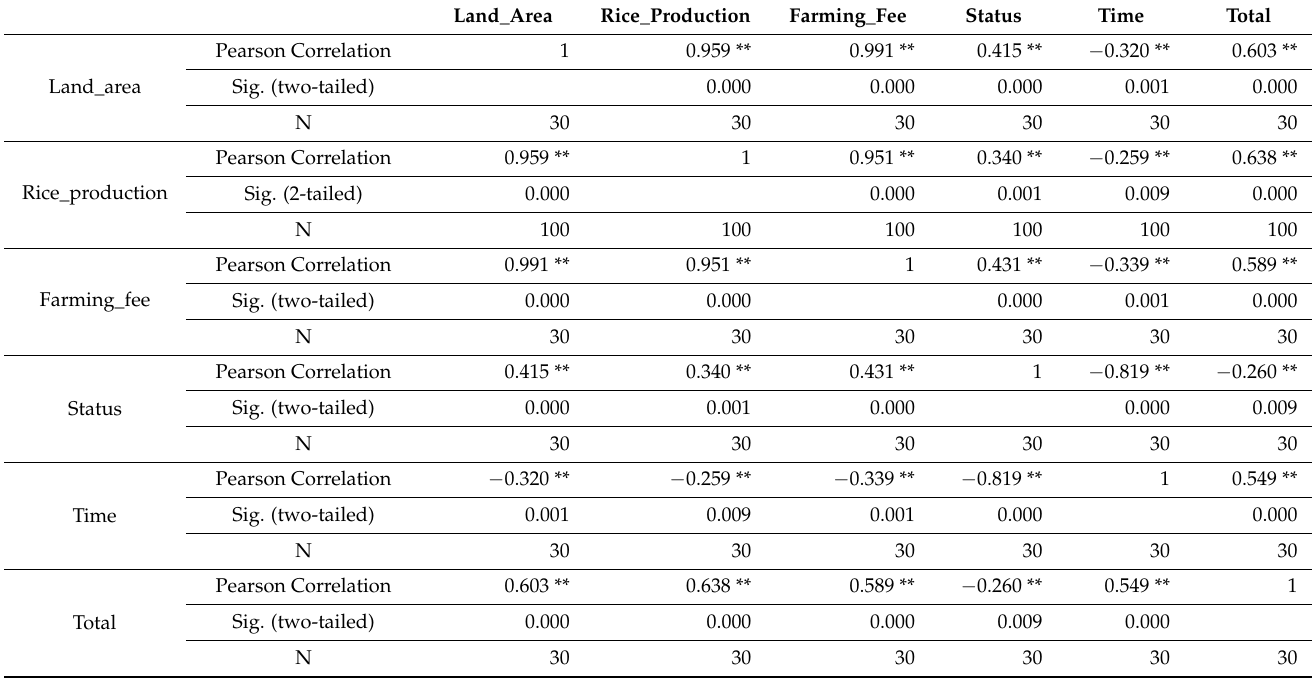
Table 3. Questionnaire validity